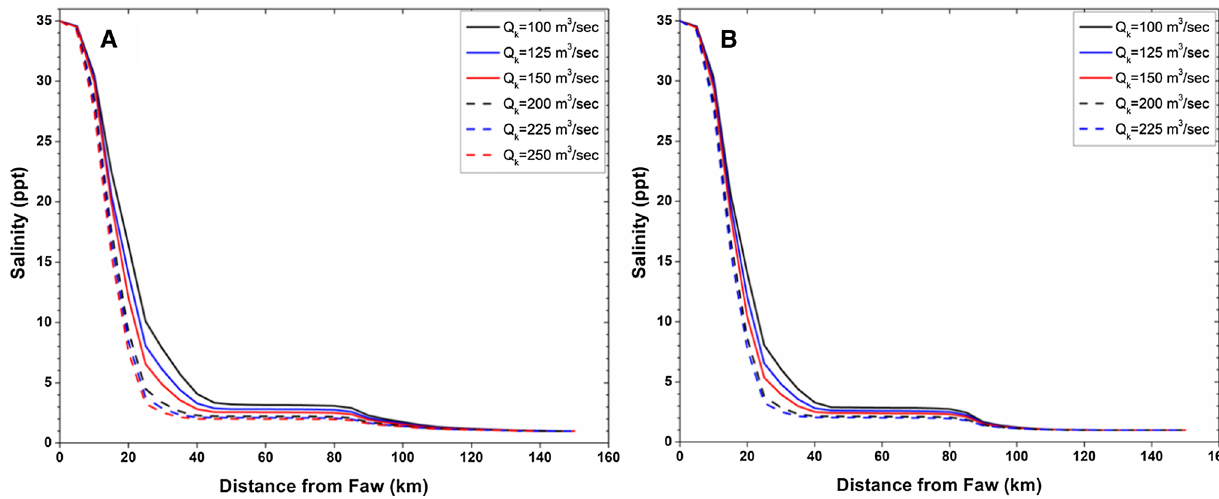
Fig. 9 Salinity intrusion limit corresponding to ( A : 25 m 3 /s and B : 50 m 3 /s) from Tigris and different flow rates from Karun